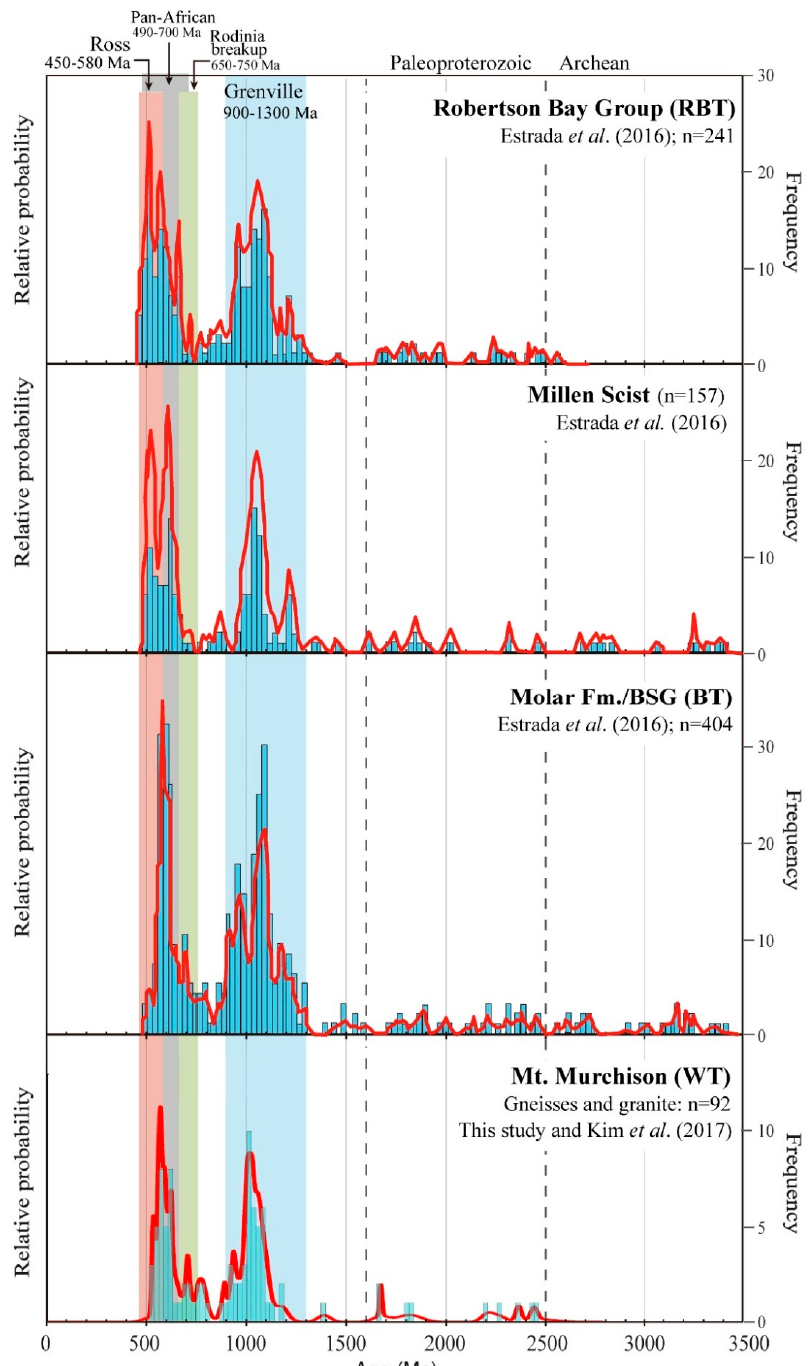
Figure 12. A comparison of detrital zircon (xenocrystic zircon for granite) ages from the major Ross-orogenic lithologies of NVL. Relative probability distribution–frequency histograms for concordant (less than 10% discordance) U–Pb ages. All three terranes (WT, BT and RBT) exhibit a similar detrital age distribution featuring the Grenvillian and Ross/Pan-African ages. The BT and RBT are especially characterized a prominent Ross-orogenic detritus. Literature data include Estrada et al. [39] and Kim et al. [48].